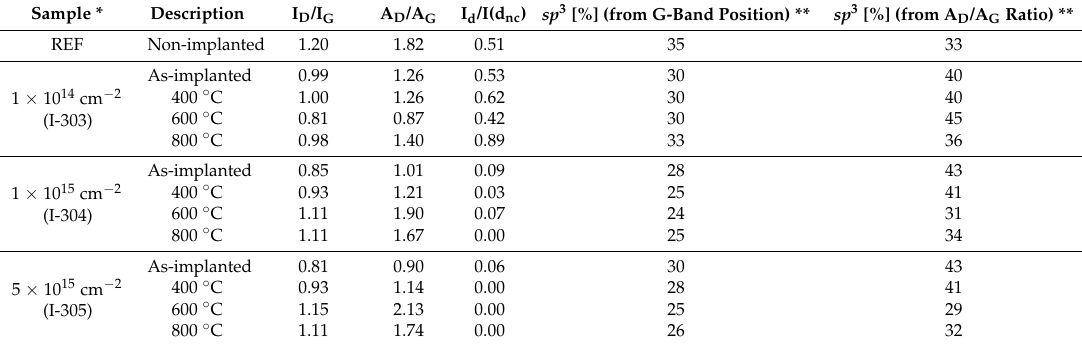
Table 3. The data evaluated from the Raman spectra deconvolution procedure for the Er-doped NCD samples.